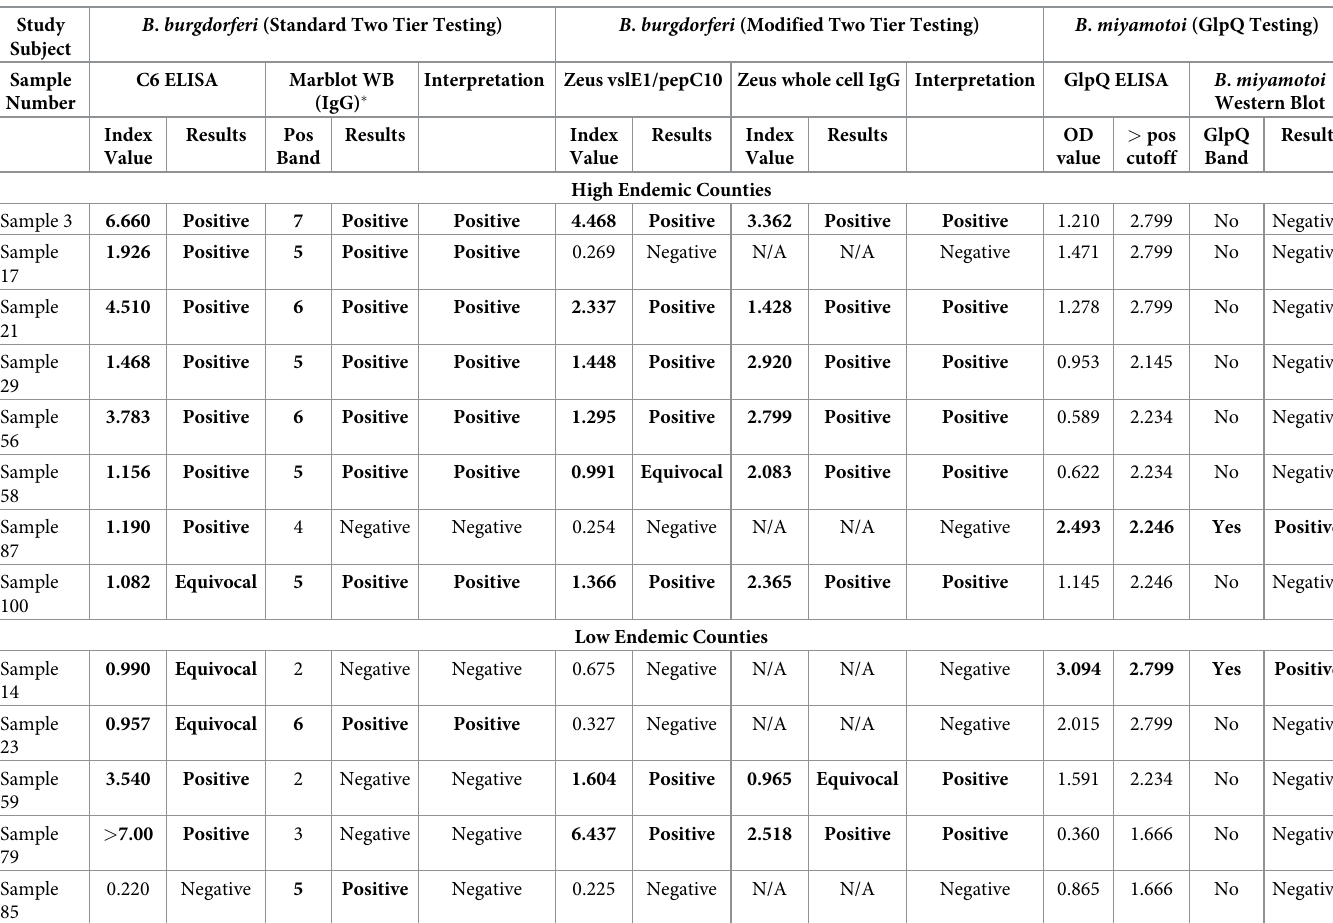
Table 3. Antibody testing results of human samples.